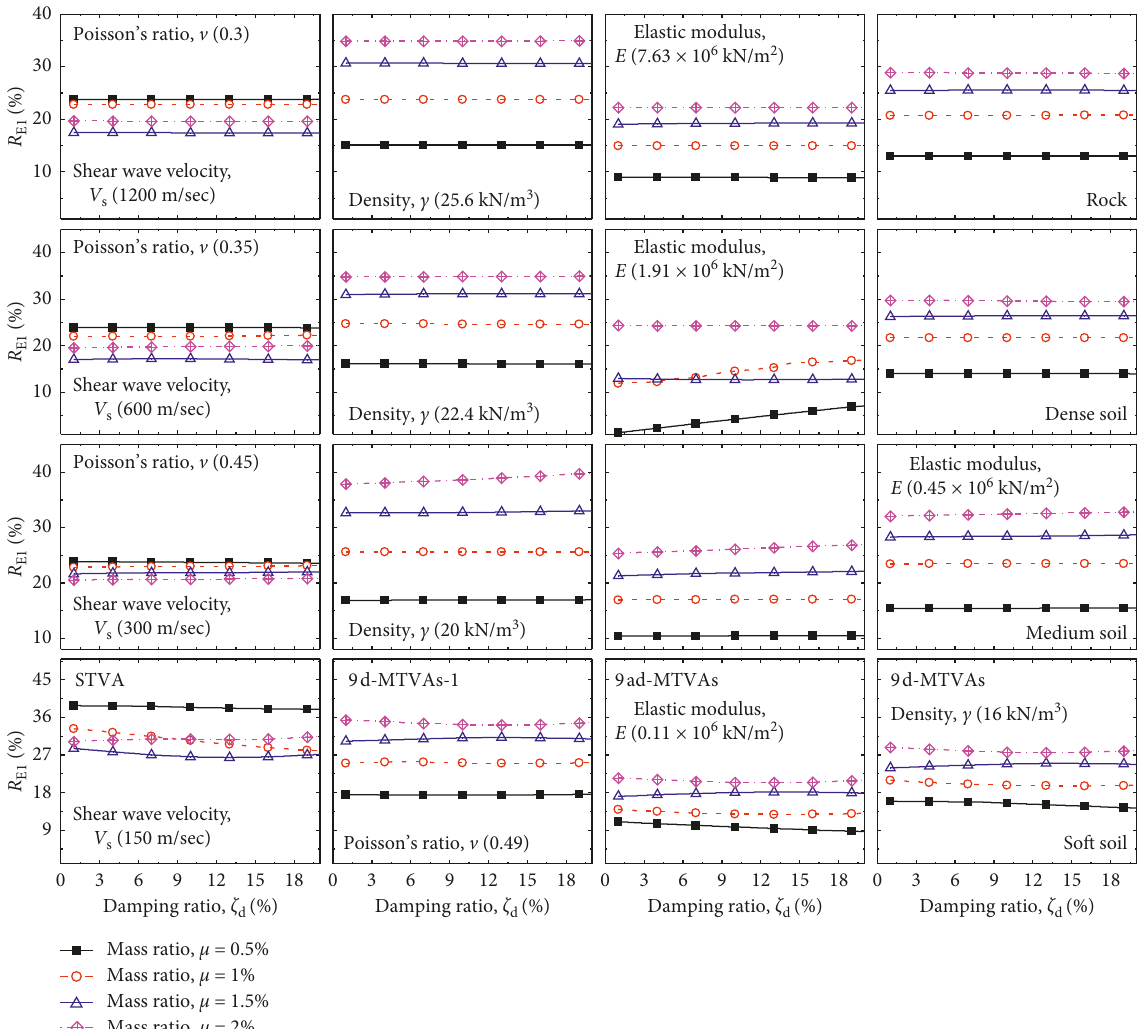
Figure 6: Variations of damping ratios ( ζ d ) for different mass ratios ( µ ) of the STVA, 9d-MTVAs-1, 9ad-MTVAs, and 9d-MTVAs installed on the chimney including SSI under Llolleo (1985) earthquake ground